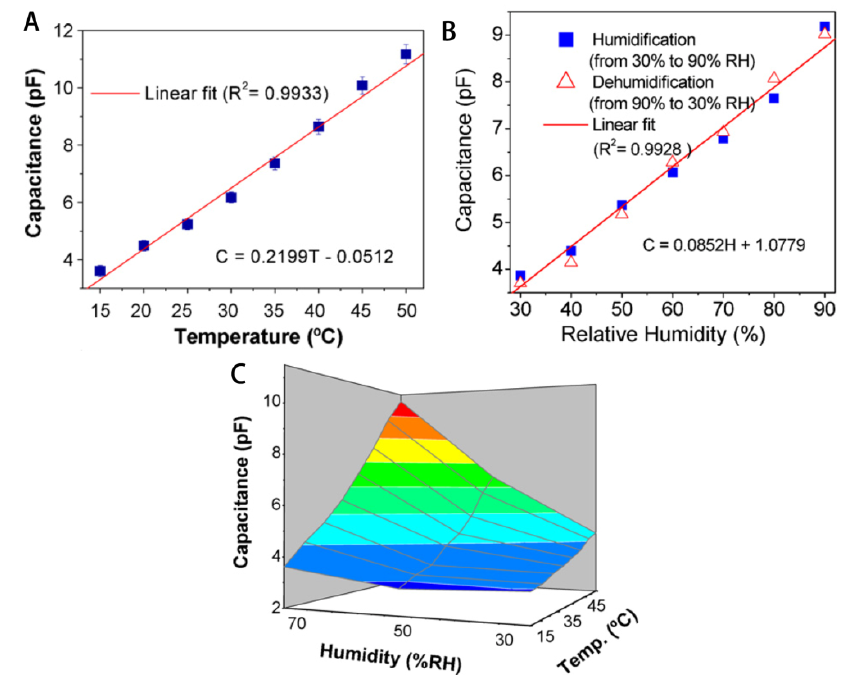
Figure 24. ( A ) Temperature-sensing characteristics at 70% RH; ( B ) Humidity sensing characteristics of cellulose-PPy nanocomposite; ( C ) Capacitance of cellulose-PPy nanocomposite sensor as a function of temperature and humidity. Reprinted with permission from [92]. Copyright 2010